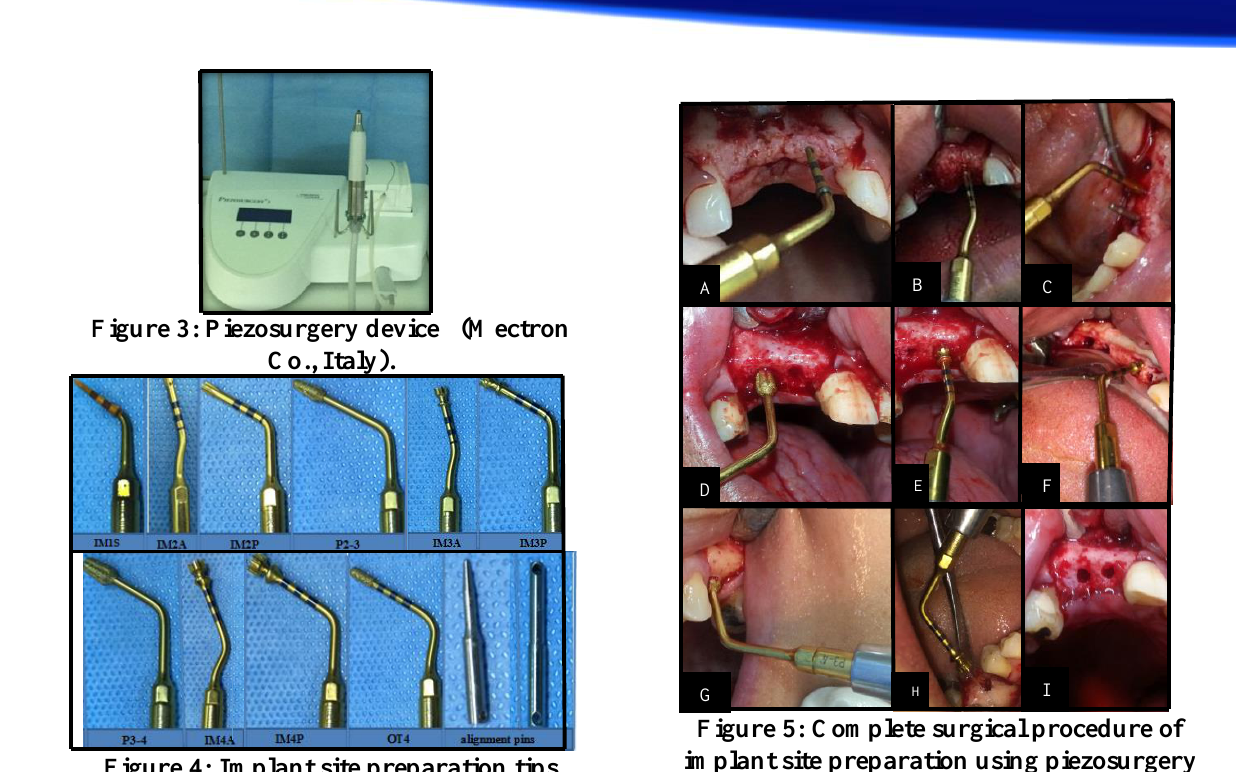
Figure 4: Implant site preparation tips (Mectron CO., Italy).